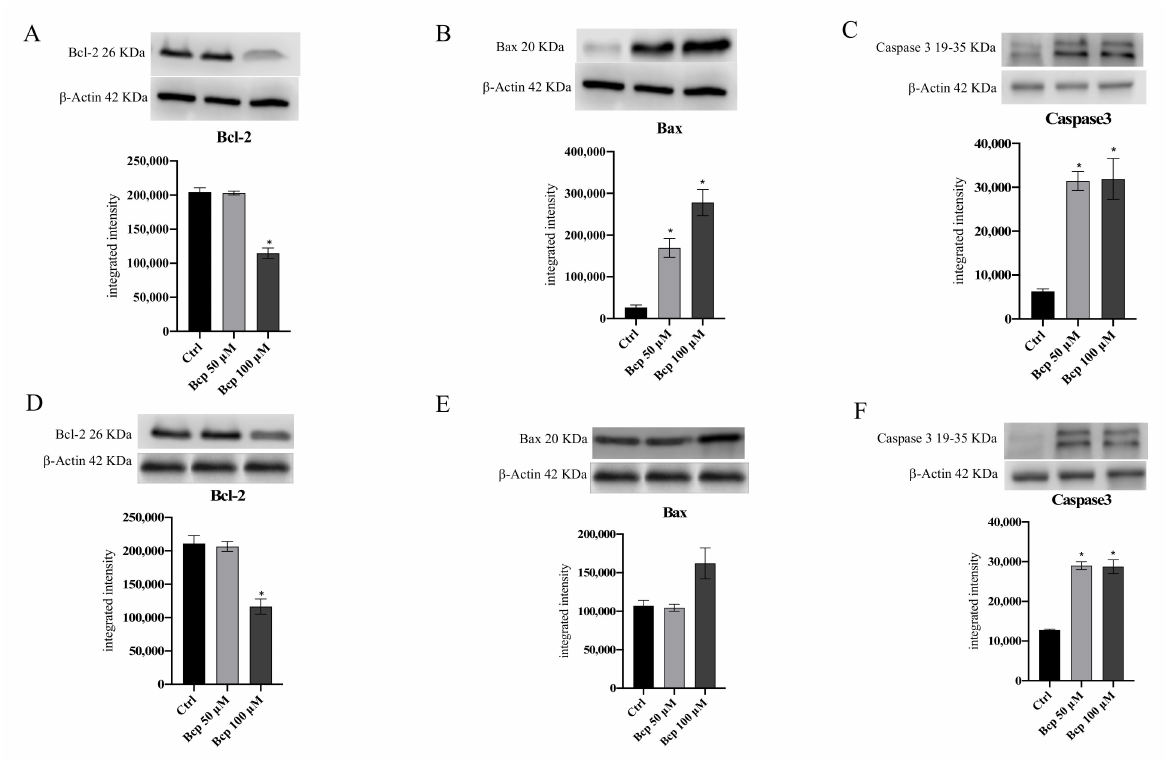
Figure 4. The graphs represent Bcl-2 ( A ), Bax ( B ), and caspase 3 ( C ) protein expression in MM.1S cells and protein expression of Bcl-2 ( D ), Bax ( E ), and caspase3 ( F ) in MM.1R cells treated with BCP. The data are expressed as means ± SEM; n = 3 experiments; * p < 0.05 vs.